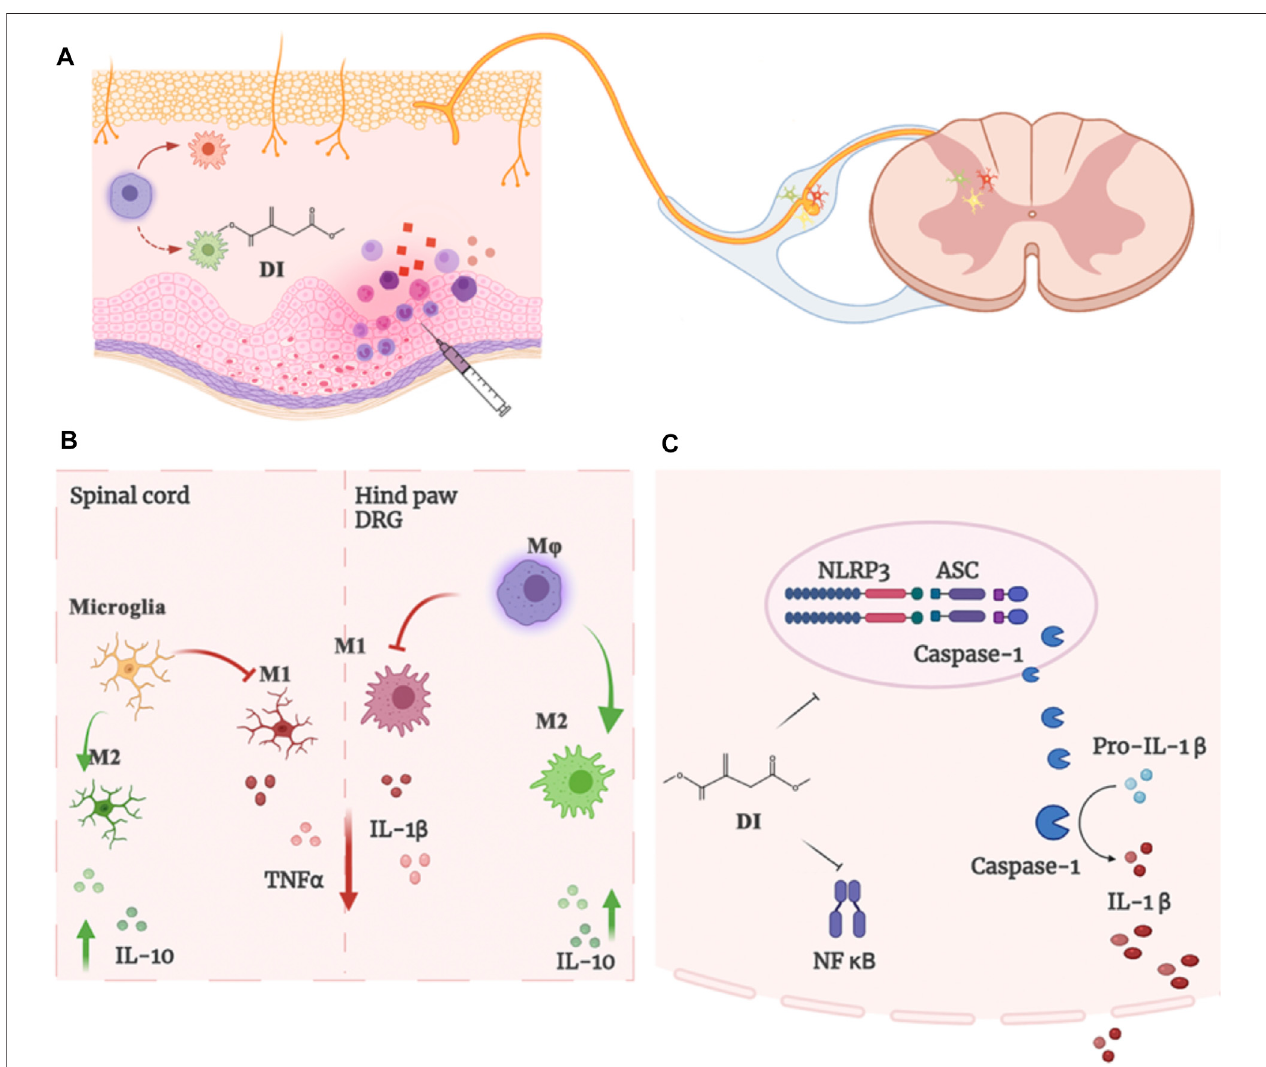
FIGURE7|(A) Theenhancedmicrogliaproliferationinthespinalcordandthein fi ltrationofmacrophagesintotheDRGandpawtissueoftheCFAmicecontributeto the development of in fl ammatory pain. (B) DI regulated and inhibited the imbalance between pro-in fl ammatory and anti-in fl ammatory responses. (C) DI suppressed the assembly of NLRP3 in fl ammasome complexes and NF- κ B, thereby inhibiting the secretion of IL-1 β .